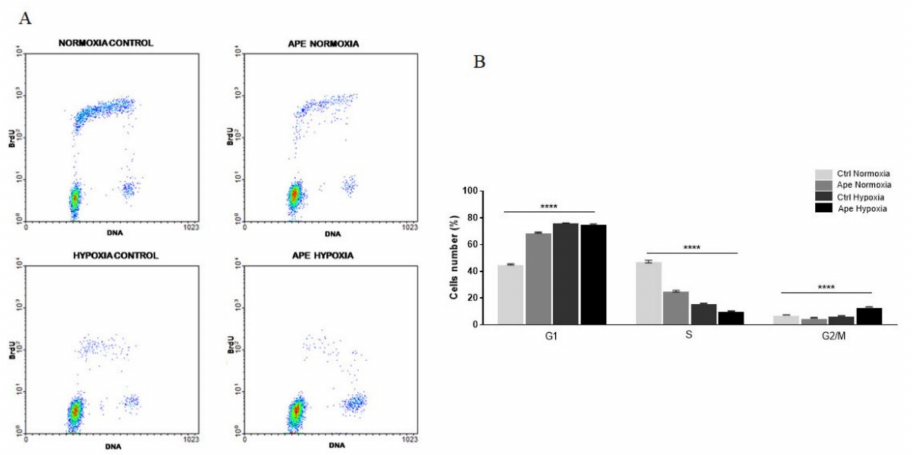
Figure 4. ( A ) Bi-parametric analysis of BrdU incorporation and DNA content in GB7 cells in normoxia and hypoxia and in presence or absence of 100 µ M Ape (24 h); ( B ) Percentage of GB7 cells in G1, S, G2 / M phases in the di ff erent experimental conditions. The data are the mean ± SEM of the three independent experiments (ANOVA test; **** p <